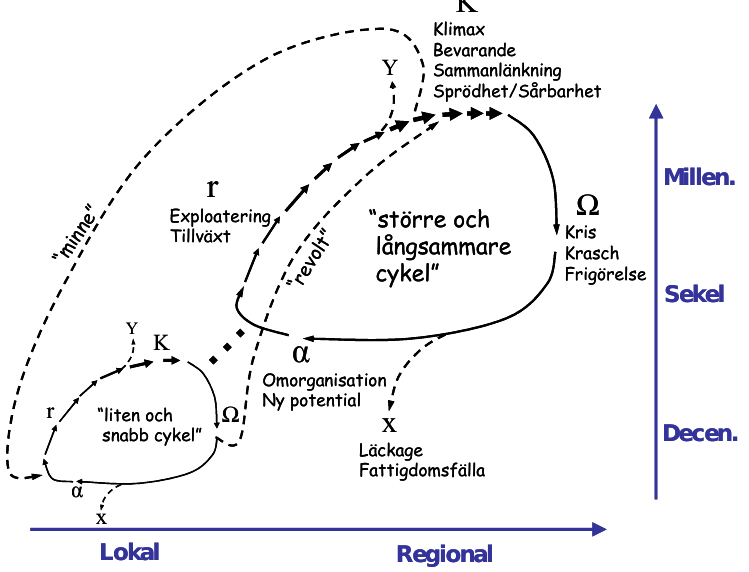
Fig. 3. Förenklad beskrivning av en hierarki av kopplade anpassningscykler (”panarki”) i olika rumsliga och tidsmässiga skalor inom ett ekologiskt, ekonomiskt eller socialt system (förenkling fritt efter Hollings (2001) adaptiva förnyelsecykel). Varje anpassningscykel utvecklas långsamt från en störningstålig (resilient) exploateringsfas ( r ) mot en klimaxfas ( K ) där alla resurser är upptagna och lite resiliens mot störningar återstår. En oväntad utmaning kan i det läget orsaka ett snabbt sammanbrott ( Ω ), som följs av antingen omorganisationer ( α ) inför ny exploatering av resurser eller resursläckage ( X ) som leder in systemet i fattigdom. Systemet kan också tänkas hamna i det motsatta, en rigiditetsfälla Y , där fortsatt anpassning inte längre är möjlig p.g.a. fastlåsta resurser, regelverk e.d. Olika hierarkiska nivåer är förbundna dels via s.k. “ revolter ”, där kritiska förändringar eller sammanbrott i lägre nivåer kan ge återverkningar i sårbara delar av högre nivåer, dels via “ minnen ” i form av fungerande system i högre systemnivåer som kan initiera eller reparera utvecklingar i lägre nivåer. Liknande tvärförbindelser i form av ”revolter” och ”minnen” kopplar också samman de ekologiska, ekonomiska och sociala systemen med varandra (se Fig. 4)